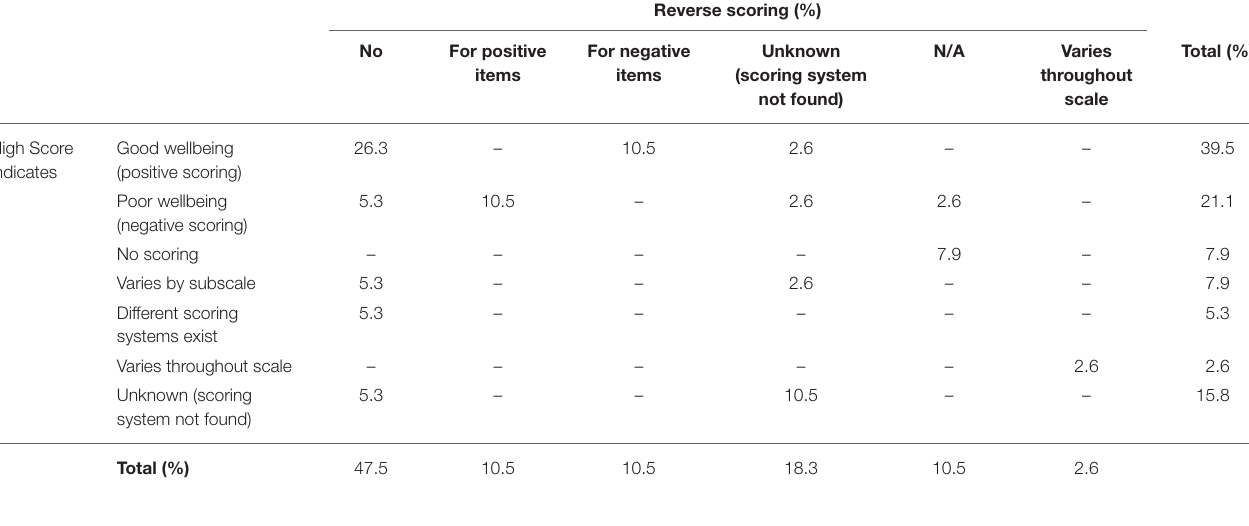
TABLE 3 | Scoring systems used by scales, N =